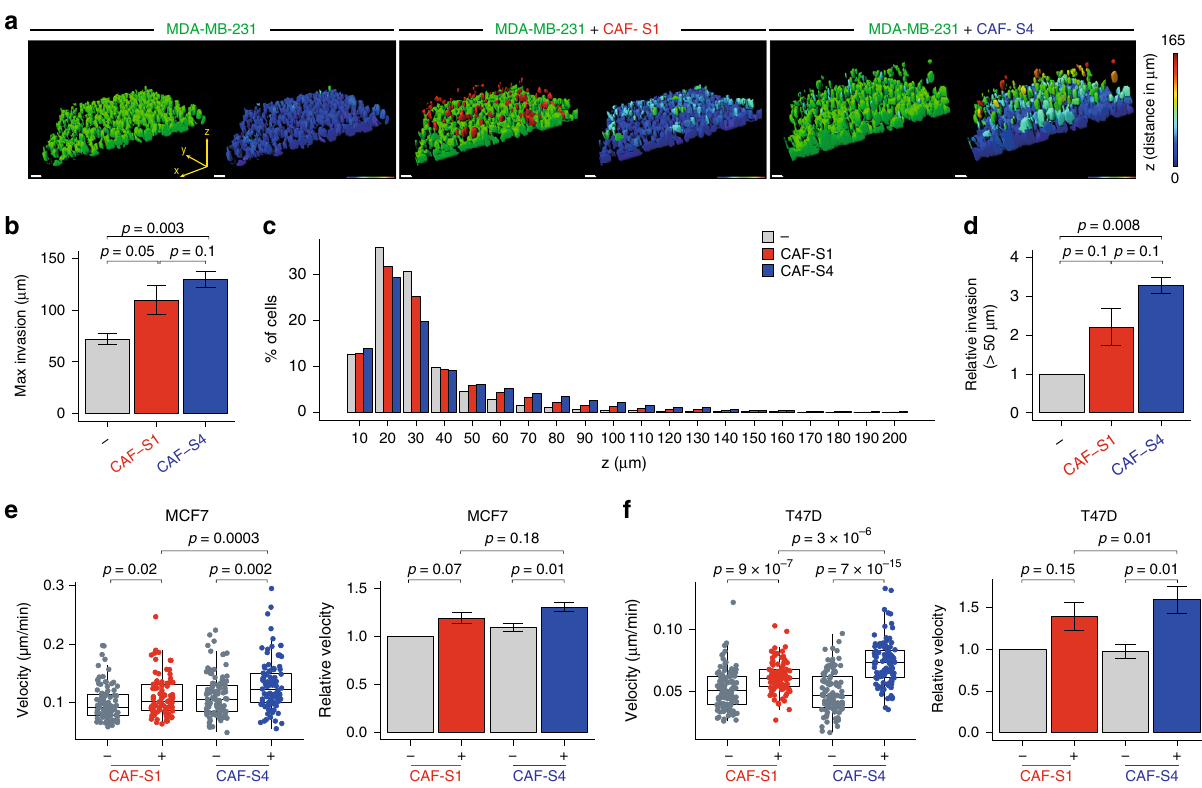
Fig. 6 CAF-S4 promote tumor cell invasion in 3D. a Representative 3D views of MDA-MB-231 invasion assessed by inverted Transwell assays, in CAF- free (left), CAF-S1- (middle) or CAF-S4- (right) embedded collagen matrix. In left images in each condition, colors show the different cell types: BC cells in green; CAF-S1 in red; CAF-S4 in blue. In right images in each condition, colors indicate the distance browsed by BC cells on the vertical ( z ) axis in 3D (maximal distance 165 μ m in red). Scale bar, 50 μ m. b Maximal vertical distance browsed by BC cells in CAF-free, CAF-S1- or CAF-S4-embedded collagen ( n = 3, ~500 BC cells per analyzed z -stack). c Mean frequency (%) of BC cells along vertical axis ( z , μ m) in CAF-free, CAF-S1- or CAF-S4-embedded collagen. d Proportion of BC cells that invaded above 50 μ m in CAF-S1- or CAF-S4-embedded collagen, relative to CAF-free condition ( n = 3, ~500 BC cells per analyzed z -stack). e Left, Representative tumor-on-chip experiment showing velocity of MCF7 in CAF-free, CAF-S1- or CAF-S4-embedded collagen. Each dot represents one cell ( n ≥ 90 cells per condition). Right, Median velocity of MCF7 in CAF-S1- or CAF-S4-embedded collagen matrix relative to CAF- free condition ( n = 3). f Same as in e for T47D. In all panels, barplots are mean ± SEM. Boxplots are median± 25% – 75% quantiles, whisker values range 1.5 × IQR above 75th or below 25th percentiles; n indicates number of independent experiments. b , d , e right: p Values from paired t -test. e left: p Values from Mann – Whitney test. At least two CAF-S1 and CAF-S4 pairs have been tested. Source data provided in Source Data fi le, with R scripts CAF-S4 (Supplementary Fig. 6i, j). In conclusion, CAF-S1 fi broblasts promote BC cell migration and EMT initiation in cancer cells in a CXCL12- and TGF β -dependent manner. In addition, CAF-S4 fi broblasts stimulate cancer cell invasion and motility in 3D by increasing contractility through the NOTCH signaling pathway.